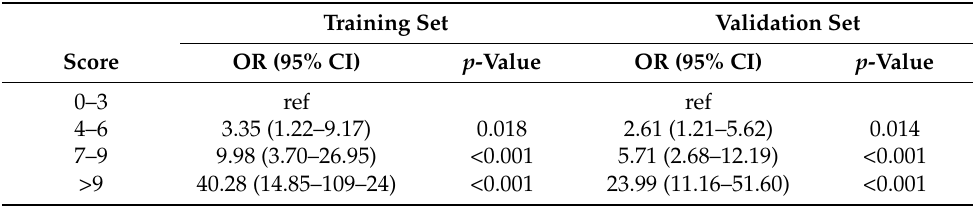
Table 3. Odds ratios for in-hospital mortality according to PRIMOF